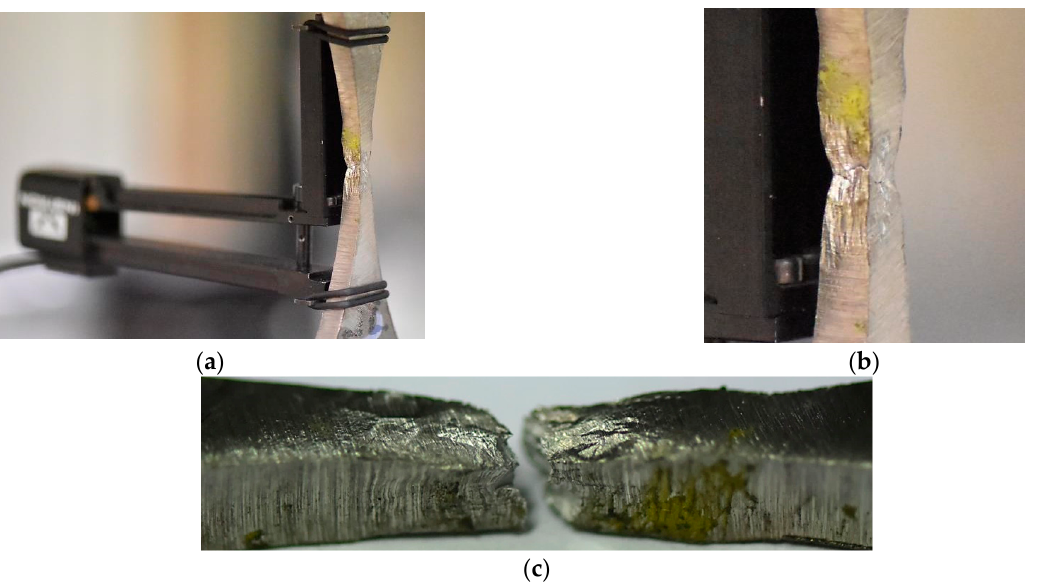
Figure 15. The MIG weld of Alloy 59 and S355J2W+N steel: ( a , b ) at the fracture, ( c ) after the fracture.